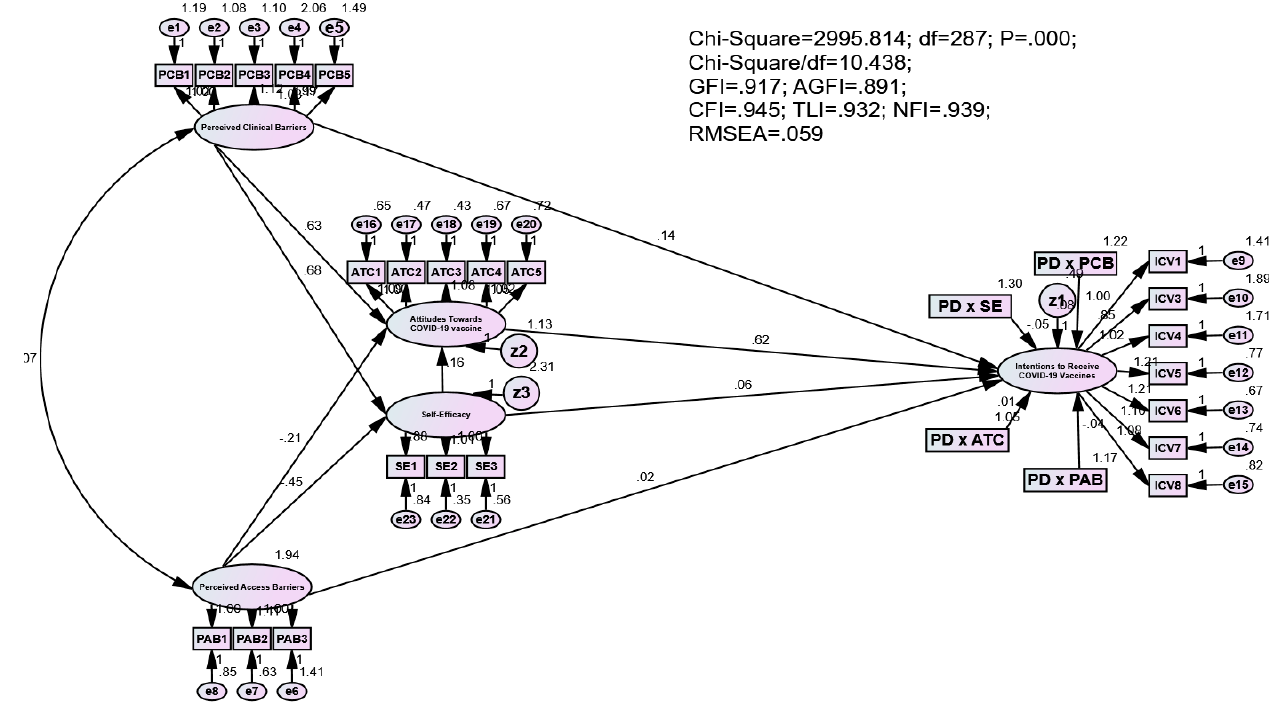
Figure 3. Structural equation modeling. Table 4. Correlations between constructs.